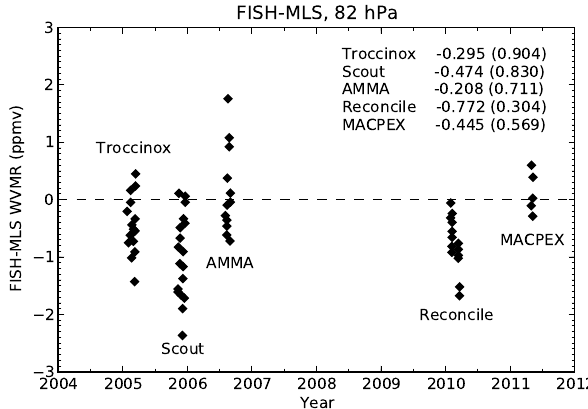
Figure 13. Comparison of FISH with MLS (Microwave Limb Sounder on the Aura satellite) for different aircraft campaigns. Mean deviation with respective SD for each campaign is given in the upper right. There are 25 matches for Troccinox, 23 for Scout, 16 for AMMA, 29 for Reconcile and 5 for MACPEX, and matches are within 12h, 5 ◦ latitude and 2 ◦